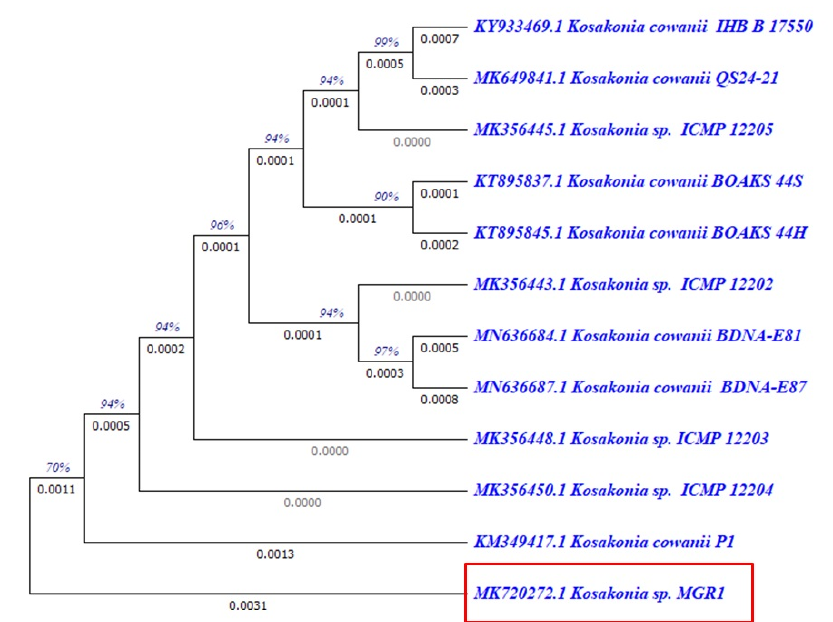
Figure 2. Phylogenetic tree and similarity analysis of Kosakonia sp MGR1. (16s rRNA-based neighbor-joining phylogenetic tree of Kosakonia sp. MGR1 with nitrogen-fixing bacteria. Zoomed in tree showing Kosakonia clade containing Kosakonia sp. MGR1 strain. The bar indicates 0.02 substitutions per nucleotide position. Values at the branches represent the percentages of 1000 bootstrap replications. Red-colored asterisks indicate Kosakonia sp. MGR1. All the 16S rRNA sequences of the genera Rhizobium , Azospirillum , Frankia , and Kosakonia were downloaded from NCBI, and their accession numbers are indicated.